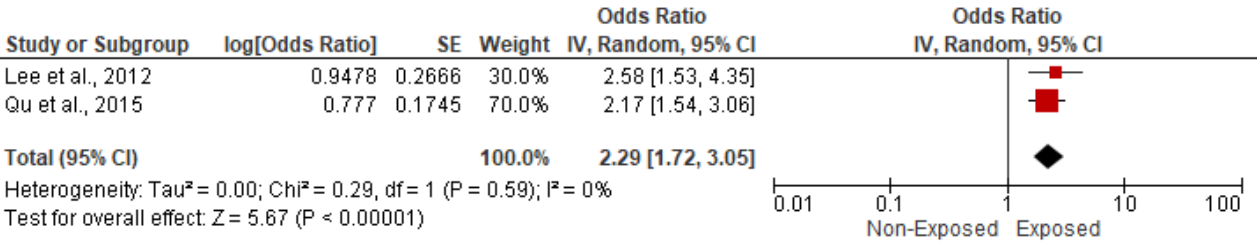
Figure 12. Forest plot of summary analysis of the Odds ratio and 95% CI of the association between HAP and heart failure. The size of the red squares is proportional to the statistical weight of each trial. The gray diamond represents the pooled point estimate. The positioning of both diamonds and squares (along with 95% CIs) beyond the vertical line (unit value) suggests a significant outcome (IV = inverse variance).